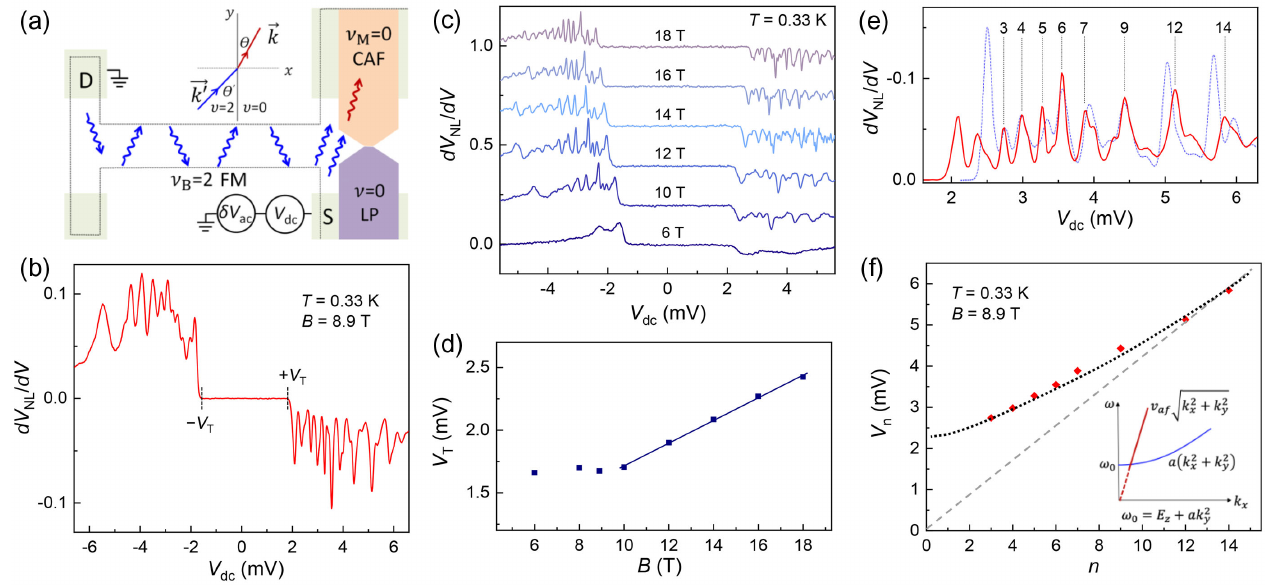
FIG. 17. SW transmission through a FM-CAF junction. (a) The measurement setup. At the ν ¼ 2 = ν ¼ 0 interface, ω ¼ ω 0 and ¼ k k =dV obtained in the setup shown in (a). The dashed lines mark the bias threshold V =dV obtained at . (b) dV . (c) plots dV y y 0 NL T NL selected magnetic fields as labeled. (d) plots the B dependence of the threshold V averaged for (cid:3) V and a linear fit to the data with a T dc > 0 , red solid line) with the corresponding trace in Fig. 4(b) (blue dotted line, slope of 0 . 09 mV = T. (e) overlays the data in (b) ( V dc expanded in V by × 4 . 55 and shifted horizontally). The remarkable overlap indicates that both arise from the FP resonance of the CAF dc region. (f) plots V vs n extracted from (e). The dotted line is a guide to the eye. From device 606. The gray dashed line has a slope of n 0 . 42 mV = mode, which is 7 times of the low- T slope in Fig. 4(e). This result indicates k ≫ k and a shallow SW incidence as illustrated y x in (a). The inset in (f) illustrates the ω − k relations in the FM (blue line) and the CAF (red line) regions. The CAF phase also supports a x gapped dispersion with ω 0 ¼ 2 E [12], but this branch is not activated due to energy z